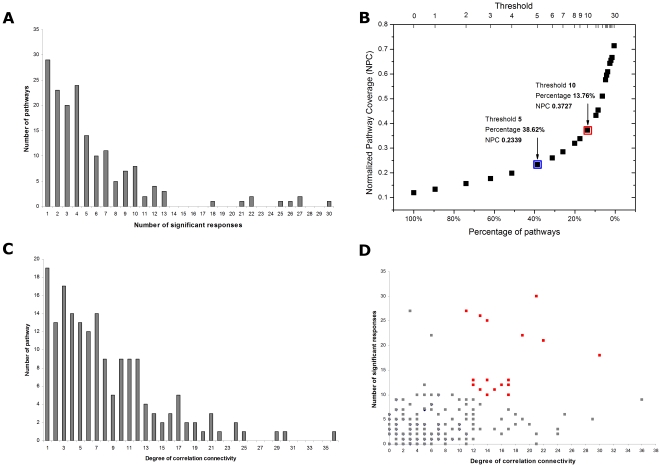
Responsiveness and connectivity of molecular pathways perturbed by chemicals.(A) Number of perturbed pathways to their respective number of significant responses across 43 distinct chemical perturbations. The graph was obtained by counting and grouping total number of 189 non-redundant molecular pathways that were significantly perturbed. Most pathways show low number of significant responds across multiple perturbations. Pathways showing same responsiveness and connectivity are plotted as one data point. (B) Normalized pathway coverage across 43 perturbations and percentage of pathways with a given cutoff threshold of significant respond. The thresholds used to define high and medium responsiveness are indicated in red and blue boxes, respectively. (C) Number of pathways with respect to their connectivity degree, as obtained from Pearson correlation analysis using NES scores across 43 perturbations as meta-activities of molecular pathways. Pairs of pathways with Pearson correlation coefficient (PCC)>0.5 or PCC<−0.5 are considered functionally connected, where the connectivity degree denotes number of functionally connected pathways to a given pathways. Most pathways show low number of functional correlations to other pathways across multiple perturbations. (D) Relation of the number of significant responds of pathways to their connectivity degree. Red spots are hubs with both high responsiveness (with at least 10 significant responds) and high degree of correlation connectivity (with at least 10 degree of connectivity). Non-hub pathways are indicated as gray spots. Most non-hub pathways show both low responsiveness and low degree of connectivity as most of them assembled at the lower left of the plot, with a smaller number of non-hubs with high degree of connectivity at lower right of the plot.